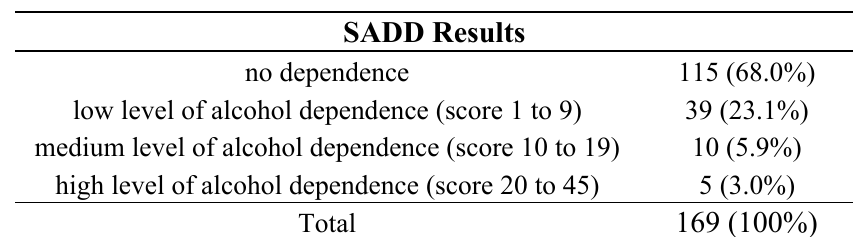
Table 2. SADD results.